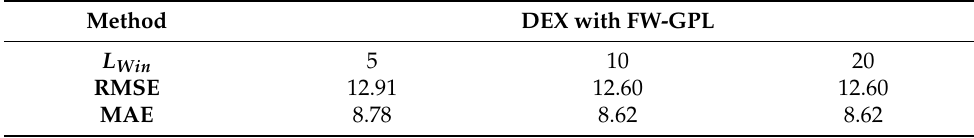
Table 9. Test performance of FW-GPL on testing data sets (length of output neurons set as 10). Method DEX with FW-GPL